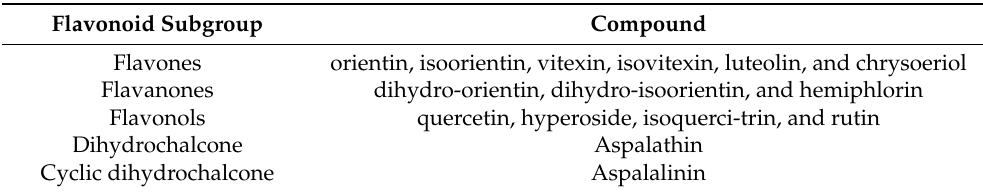
Table 2. List of some secondary metabolites found in A. linearis